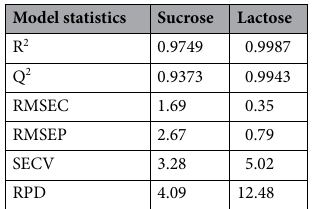
Table 3. Statistical values for the PLS prediction using the training and internal validation milk